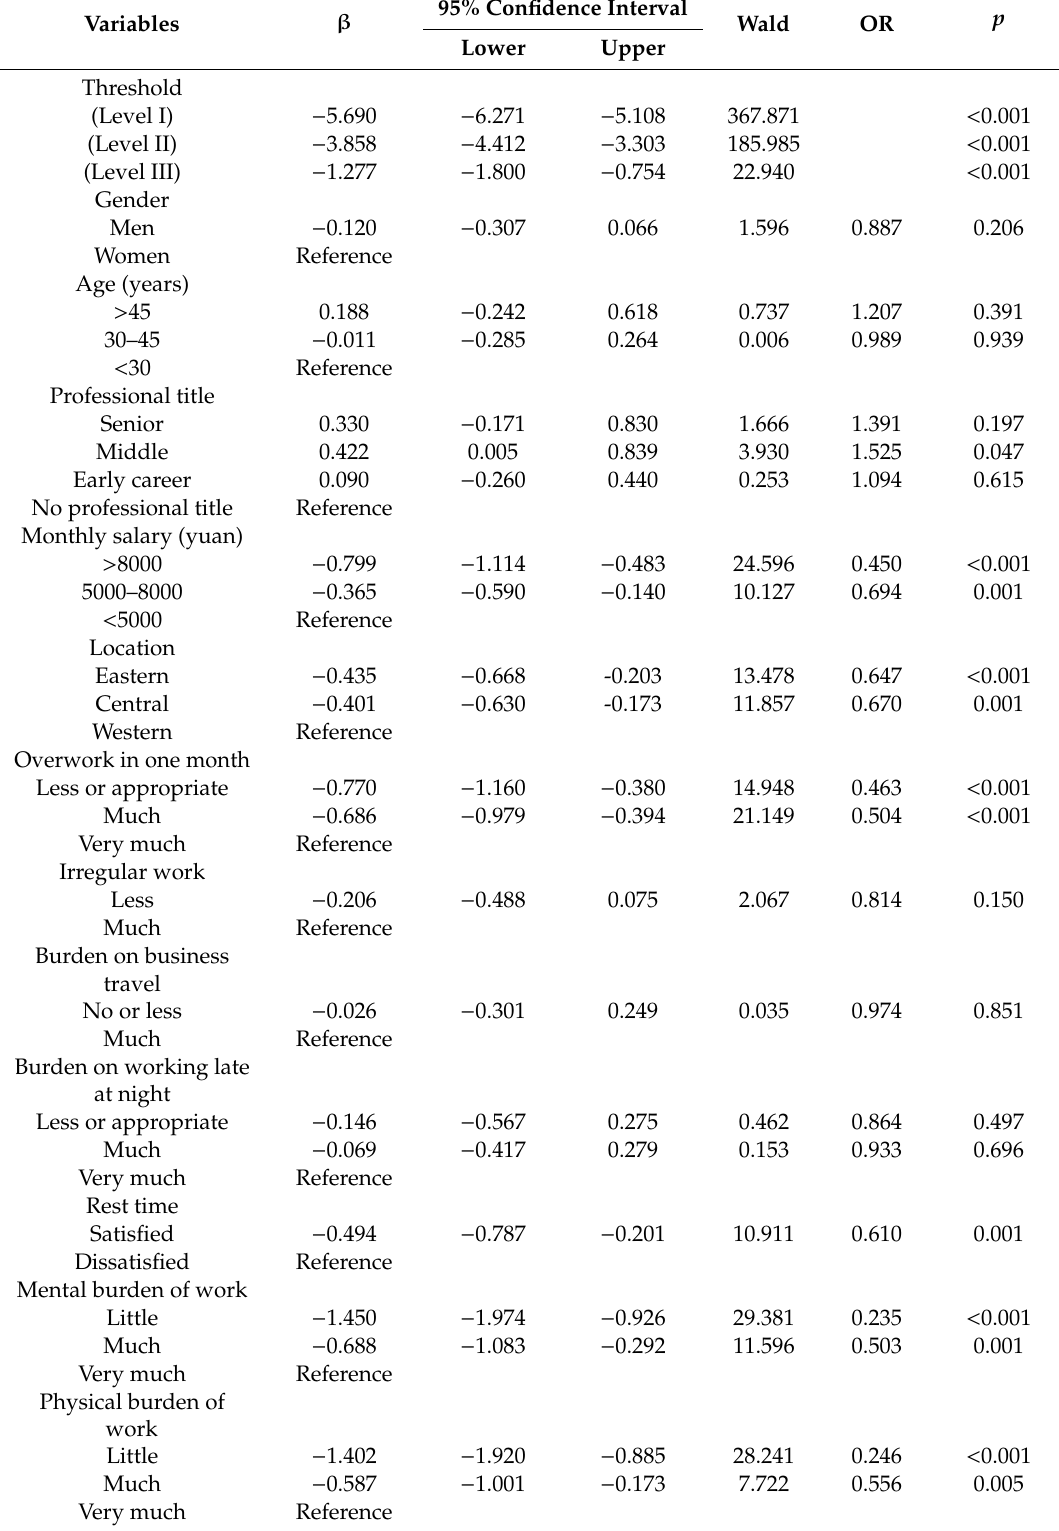
Table A2. Ordinal logistic regression modelling on accumulated fatigue with multiple work status